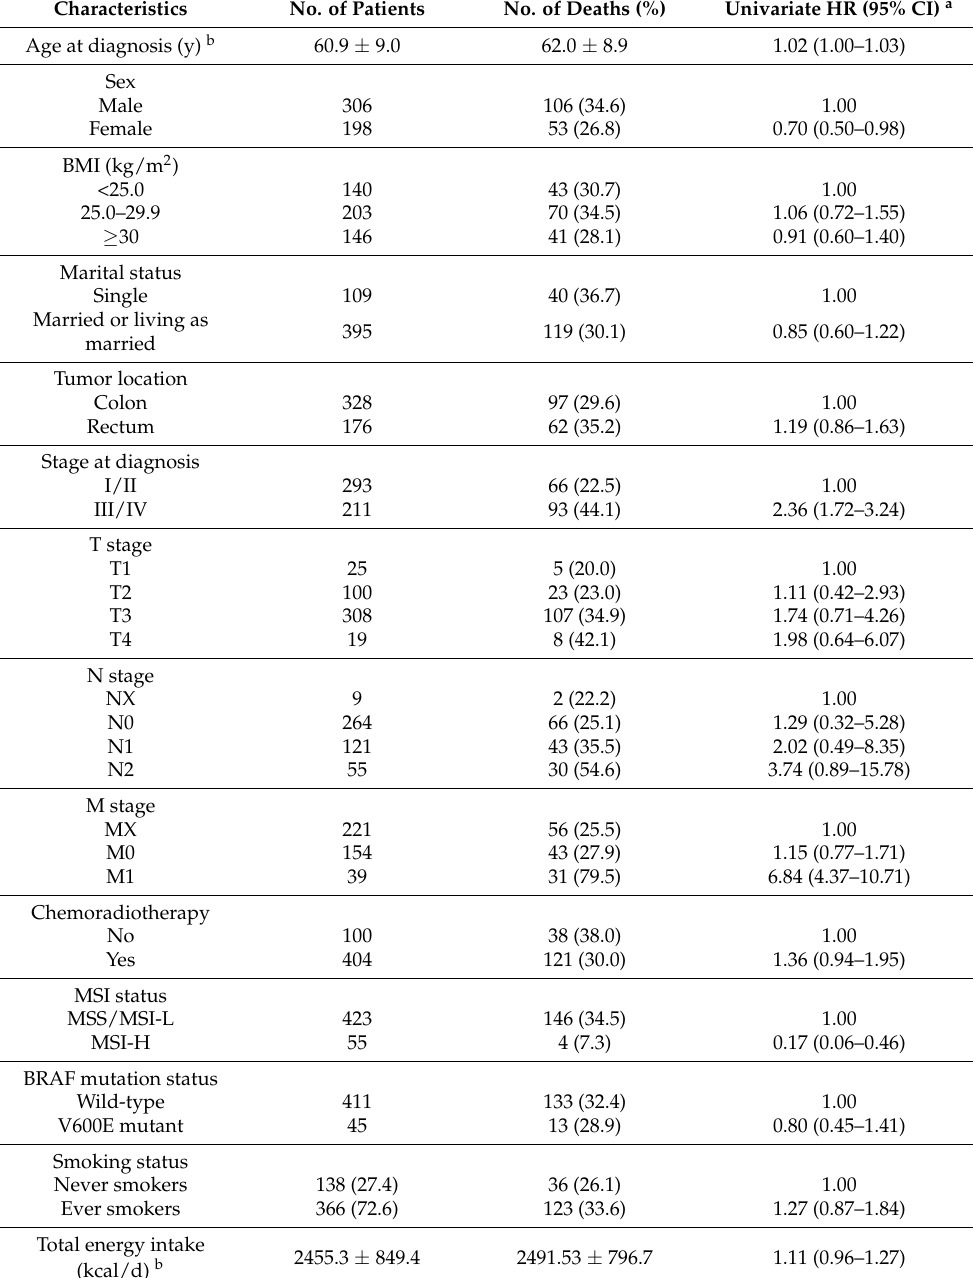
Table 1. Demographical and clinicopathological characteristics of study population in the Newfound- land study ( n =